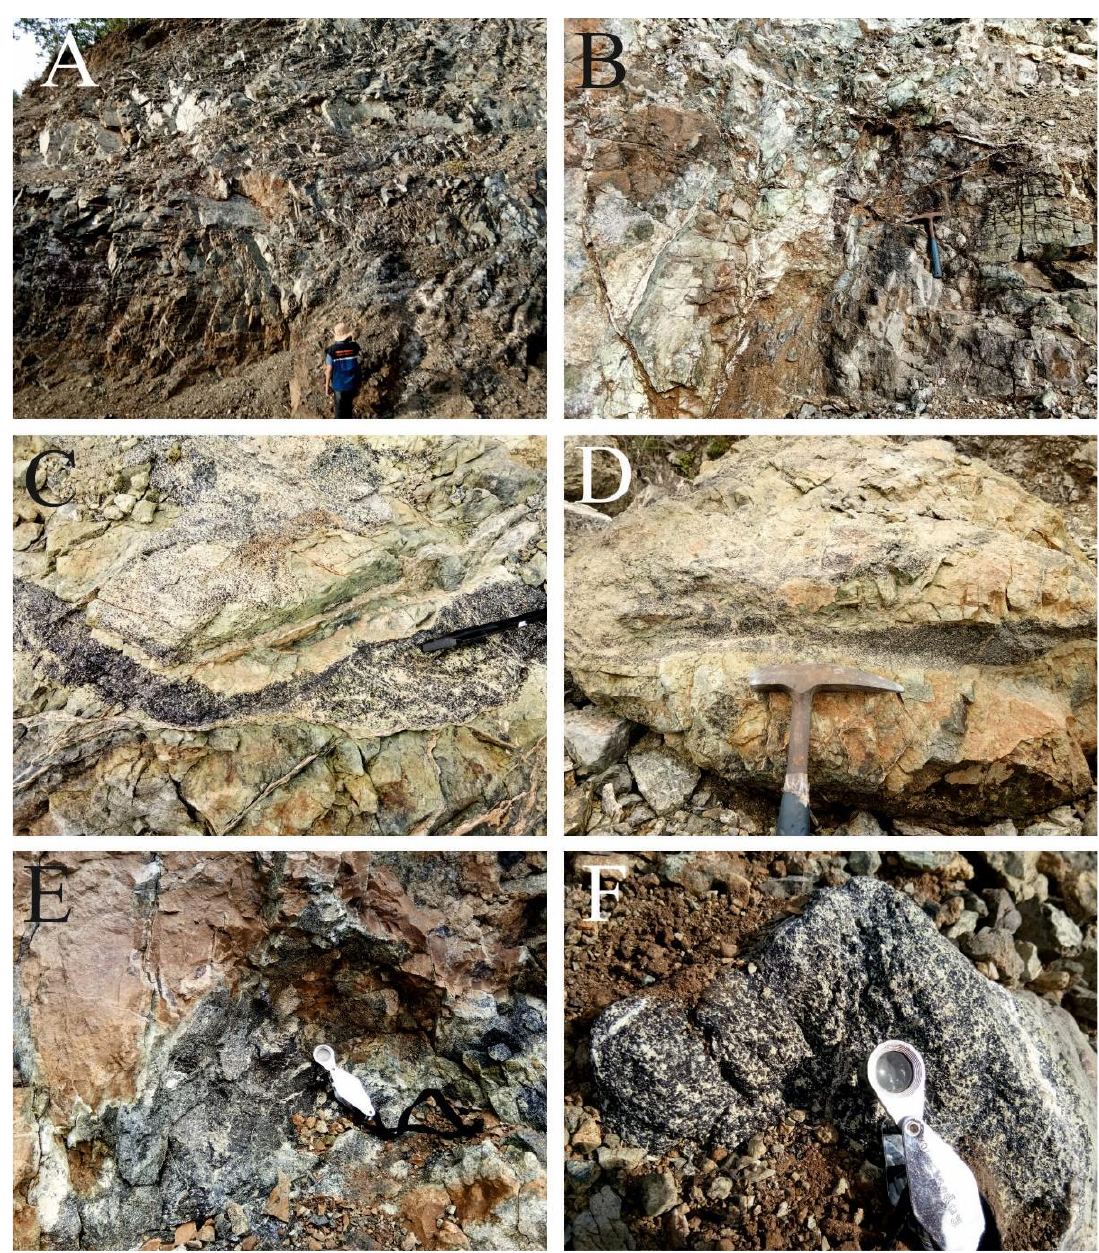
Figure 4. Field images of the Kabaena Island chromite deposits studied in this work. Overview of the altered peridotite hosting small bodies of chromitite ( A , B ), Schlieren-type and vein-shaped chromitite ( C , D ), a massive pod of chromitite ( E ), and nodular chromitite ( F ).